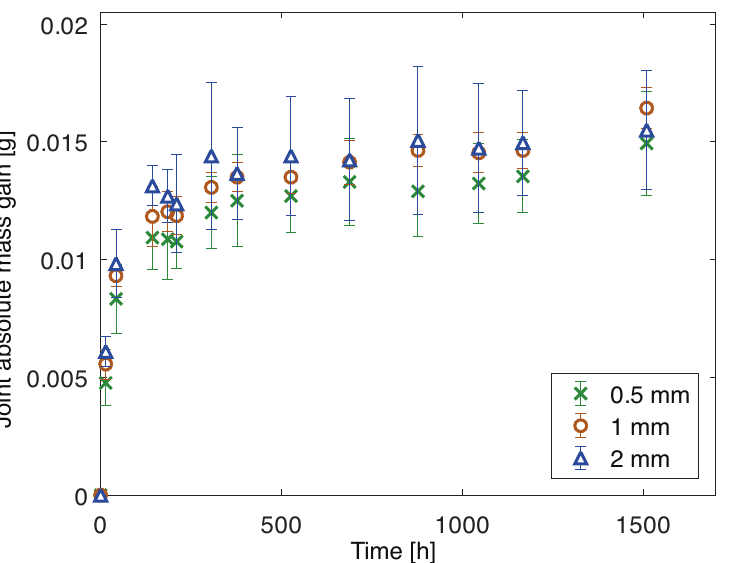
Figure 16. Mass gain due to water uptake of joints (adhesive, substrate and interphase) with PBT- GF30 substrates and 0.5 mm, 1 mm, and 2 mm thick